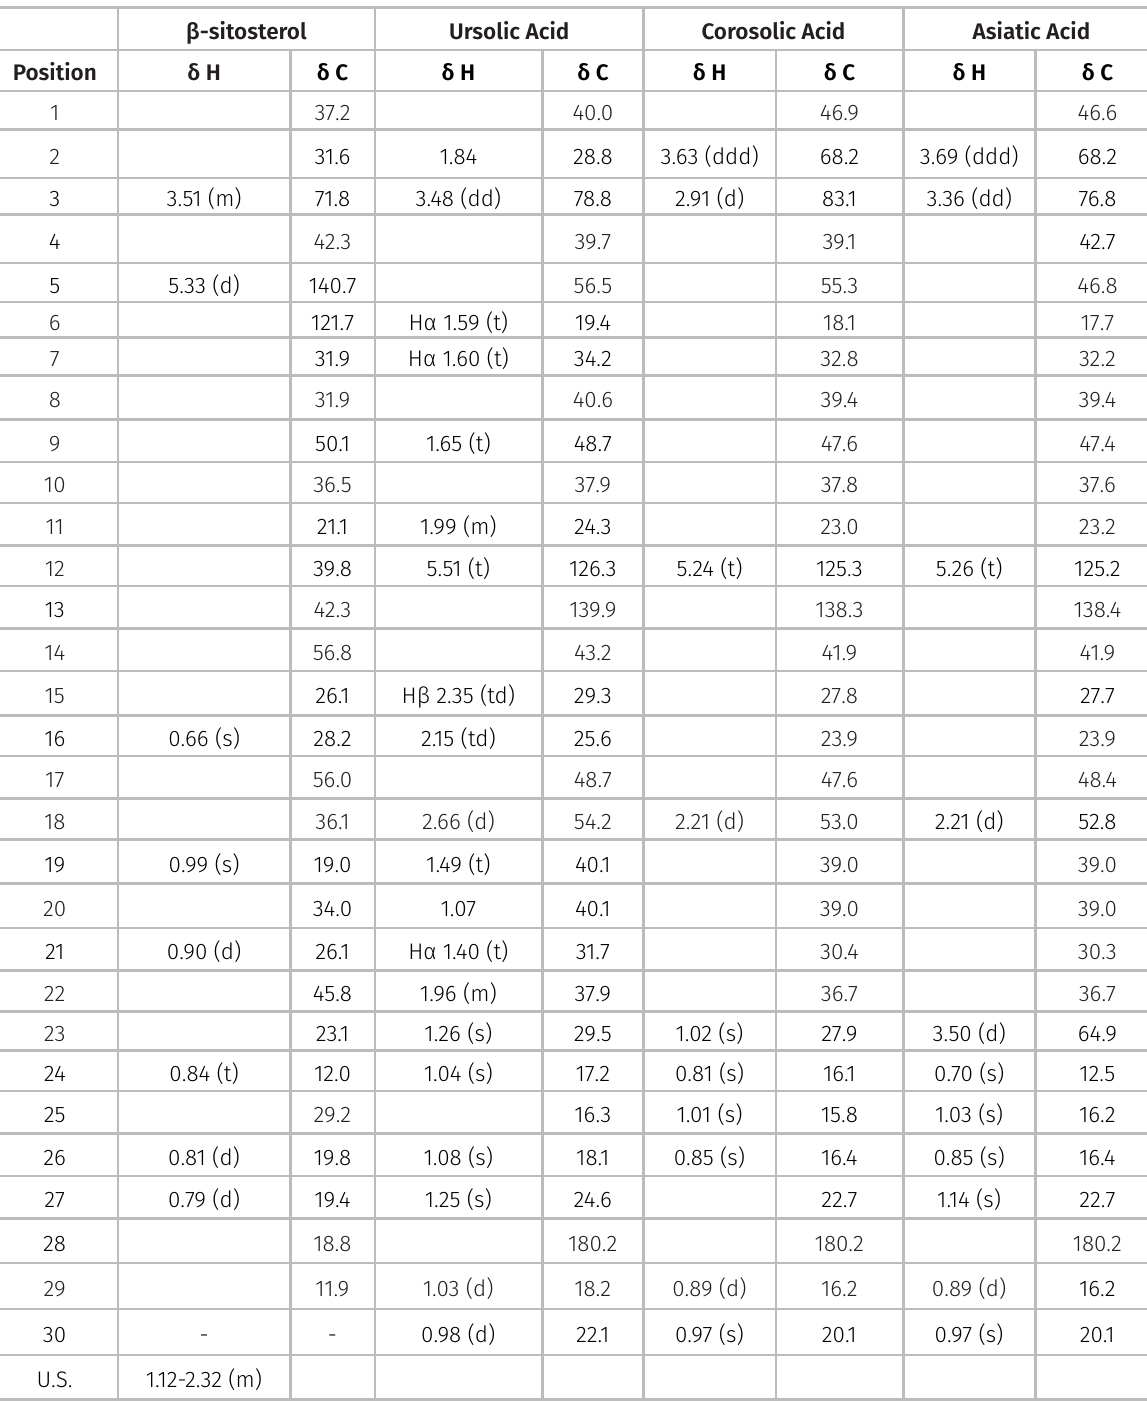
Table I. 1 H. and 13 C-NMR Data of Compounds 1, 2, 3 and 4, in ppm. Assignments of 13 C-NMR data were accomplished with the aid of DEPT, HSQC and HMBC experiments. β-sitosterol Ursolic Acid Corosolic Acid Asiatic